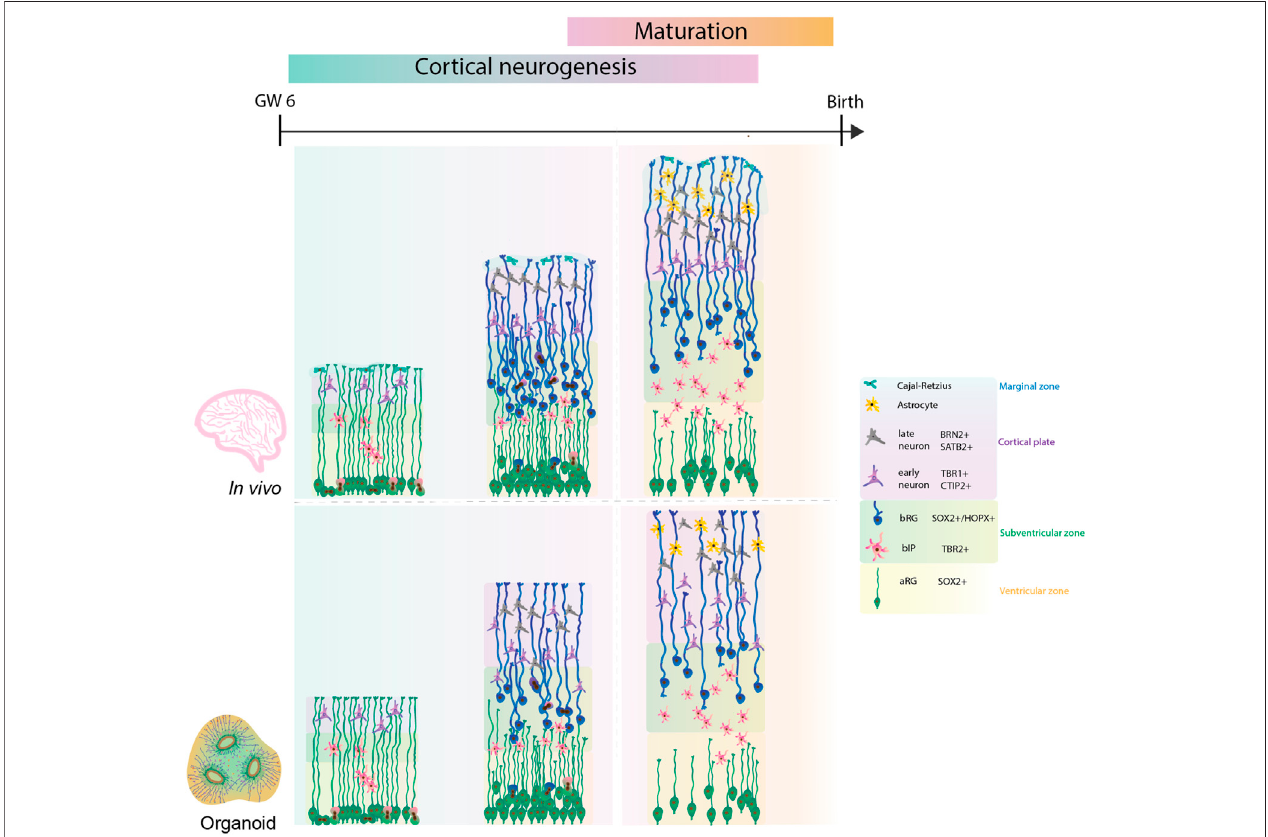
FIGURE 1 | Comparison of human cortical development between human fetal neocortex and human forebrain organoids. Cortical neurogenesis in human fetal development (upper panel) starts with proliferation of neural progenitor cells. In this process, bRG are highly abundant and give a key contribution to the fi nal neuronal output.Consequently,theneocortexexpandsintospeci fi ccytoarchitecturallayerswithformationofcorticalfoldingonthebasalside.Followingneurogenesis,functional maturation of neurons and glia takes place. Human forebrain organoids (lower panel) recapitulate the cell diversity and developmental lineages, however further improvements are required to achieve bRG abundance, improved cytoarchitectural organisation, neuronal and glial maturation, and cortical folding similar to the ones observed during the human fetal neocortex.